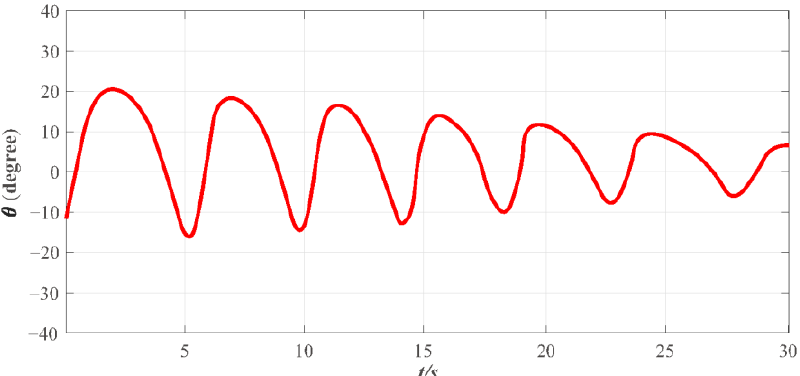
Figure 10. The variation of impedance angle 𝜃 under the designed FT-NITSM resonant frequency tracking controller.